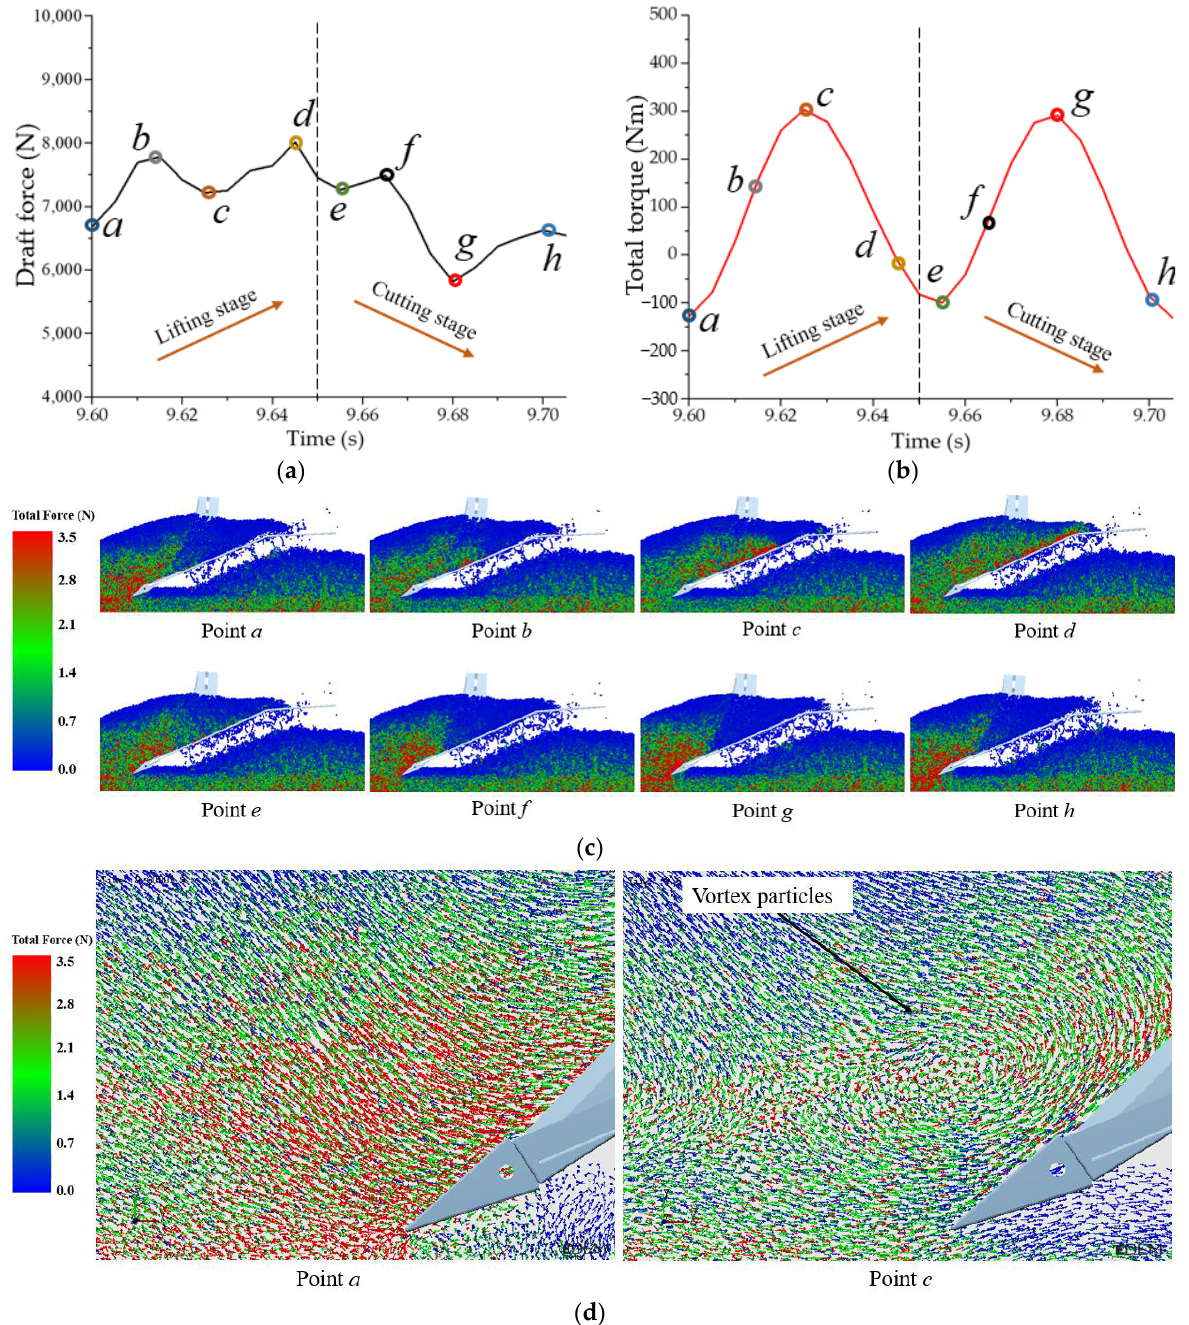
Figure 15. The points a –h are the draft force’s extreme points of the draft force ( a ) and their corre- sponding positions in total torque ( b ) curves for a working cycle, ( c ) showing the forces on soil at each point, and ( d ) listing the soil vector flow at points a and c.